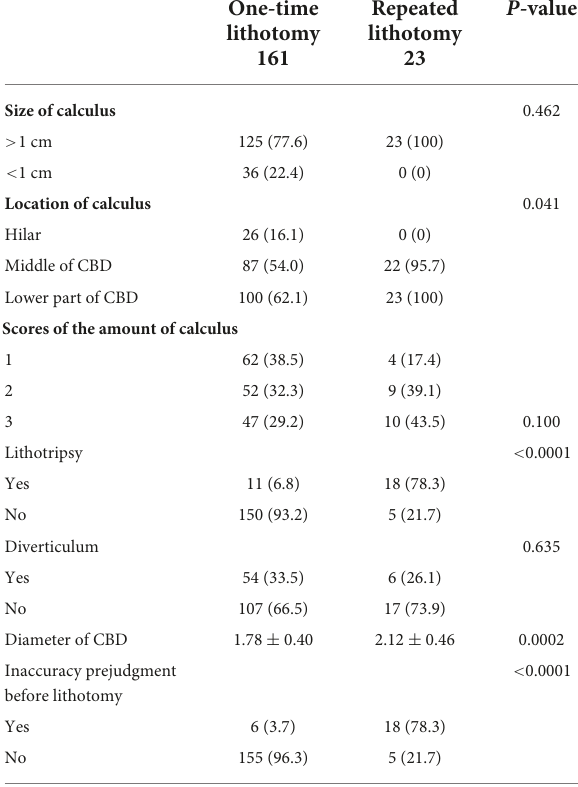
TABLE 4 Post hoc analysis: features of calculus and anatomy in RL